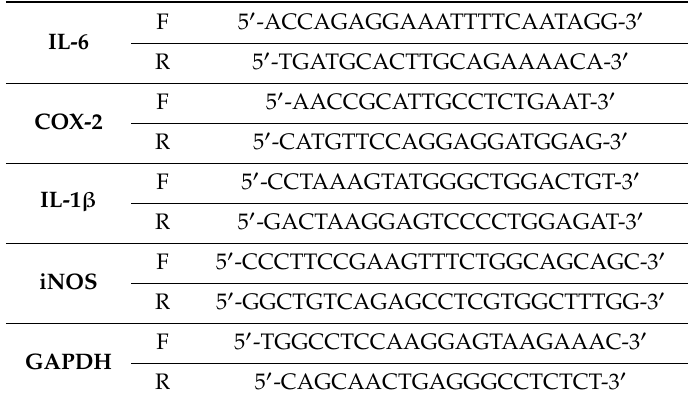
Table 1. mRNA primer sequence for Quantitative Real-Time RT-PCR